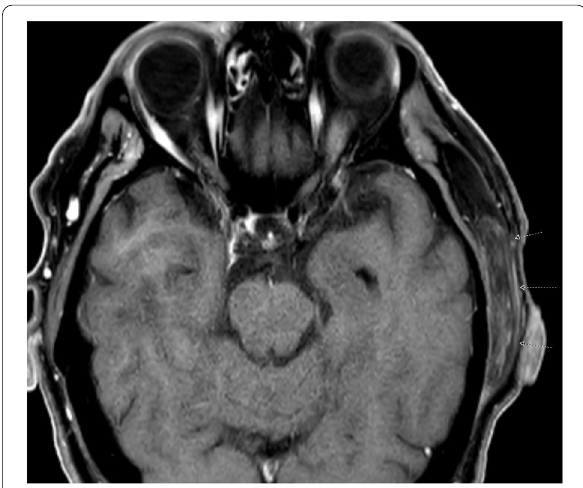
Fig. 2 Coronal T1 image with fat saturation after gadolinium injection showing enhancement of the septa within the lesion